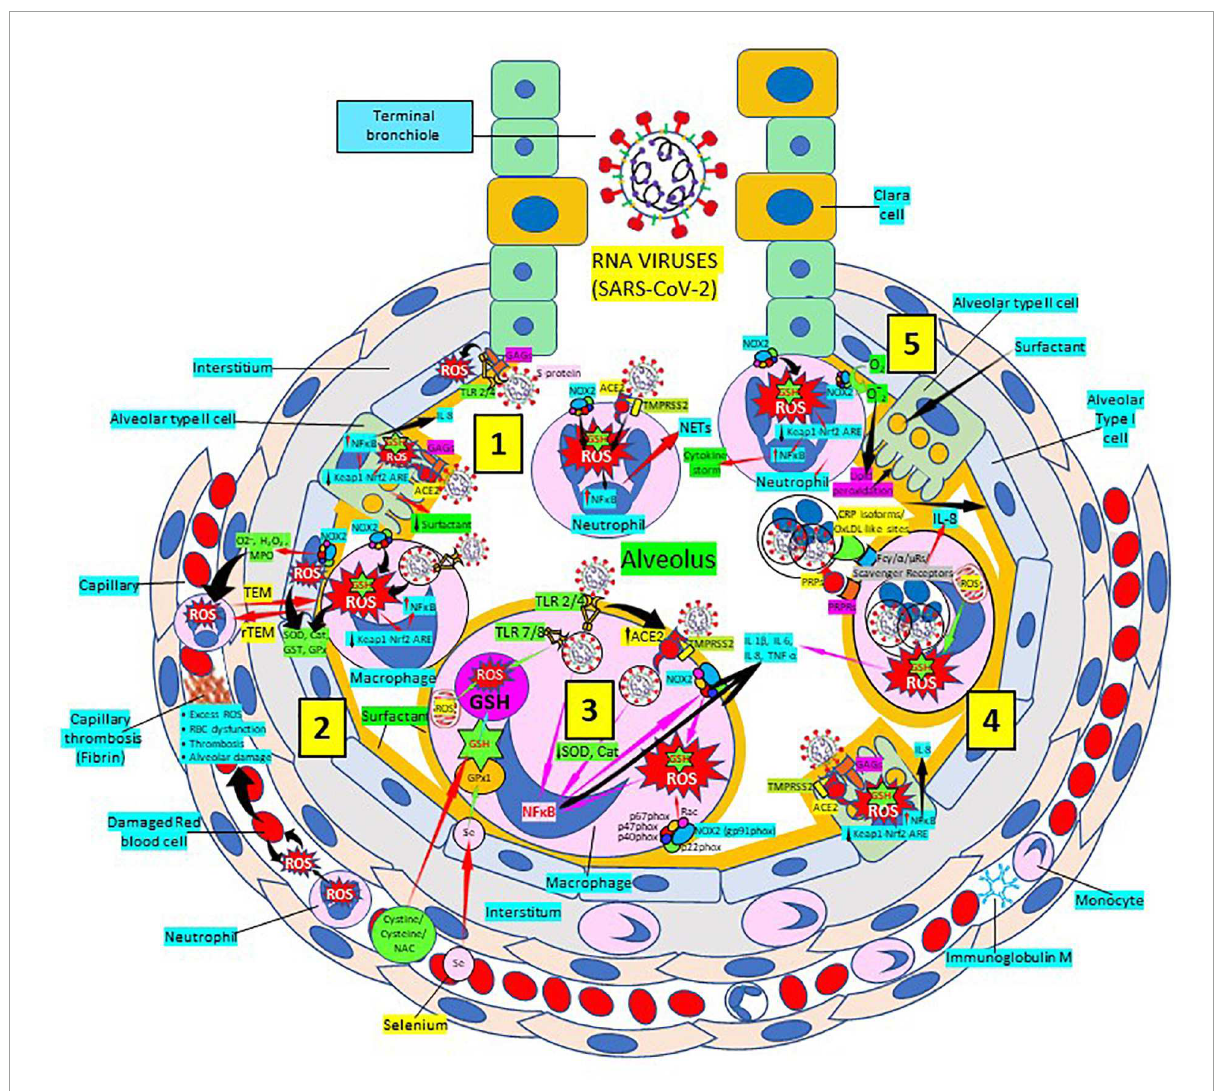
FIGURE8 Severe acute respiratory syndrome coronavirus 2 (SARS-CoV-2) pulmonary infection, oxidative stress and antioxidant defenses. (1) After entry of SARS-CoV-2 into the alveolus, viruses invade type II alveolar cells through angiotensin-converting enzyme 2 receptors (ACE2) and glycosaminoglycans (GAGs) [see (4)], and infected cells increase reactive oxygen species (ROS) production, reduce Kelch-like ECH-associated protein 1 (Keap1)-Nuclear factor erythroid 2-related factor 2 (Nrf2)-antioxidant response element (ARE) redox regulator pathway and become defective for surfactant production. Infected cells activate nuclear factor (NF)- κ B and release cytokines like interleukin (IL)-8. Alveolar type I cells augment ROS production via toll-like receptors (TLRs) 1 and 2. SARS-CoV-2 enhances neutrophil extracellular trap (NET) release and increases ROS production (2) SARS-CoV-2 augments macrophage’s ROS production, inhibiting Nrf2 activation and enhancing NF- κ B upregulation. ROS are counterbalanced by enzymes like superoxide dismutase (SOD), catalase (Cat), glutathione S-transferase (GST), and glutathione peroxidase (GPx) to protect cells from oxidative damage caused by nicotinamide adenine-dinucleotide phosphate (NADPH) oxidase 2 (NOX2), superoxide (O 2 − ), hydrogen peroxide (H 2 O 2 ), and myeloperoxidase (MPO). Capillary neutrophils migrate to and from alveoli by trans- endothelial (TEM) and reverse transmigration (rTEM), respectively. SARS-CoV-2 infection can cause excessive ROS production in capillaries, red blood cell (RBC) dysfunction, thrombosis and alveolar damage. (3) Activated alveolar macrophages release increased levels of IL-1 β , IL-6, IL-8, and tumor necrosis factor (TNF)- α . SARS-CoV-2-infected macrophages ( via ACE2 and TLRs) reduce enzymes like SOD and Cat, among others, and activate NF- κ B. NOX2 activation increases ROS production that enhance NF- κ B activation. Glutathione (GSH) precursors (Cystine, cysteine, N-acetyl cysteine, NAC), and selenium (Se) restore GSH and GPx, respectively, to counteract the effects of ROS. (4) Alveolar macrophages engulf SARS-CoV-2-infected apoptotic cells via Fc ( γ / α / µ ) and scavenger receptors and/or pattern recognition protein receptors (PRPRs) leading to increased ROS production and cytokine release. (5) Neutrophils contribute to O 2 − production, lipid peroxidation and increased oxidative stress to promote the cytokine storm. Abbreviations: TMPRSS2, Transmembrane protease Serine 2; PRPs, pattern recognition proteins. Reprinted from Labarrere and Kassab